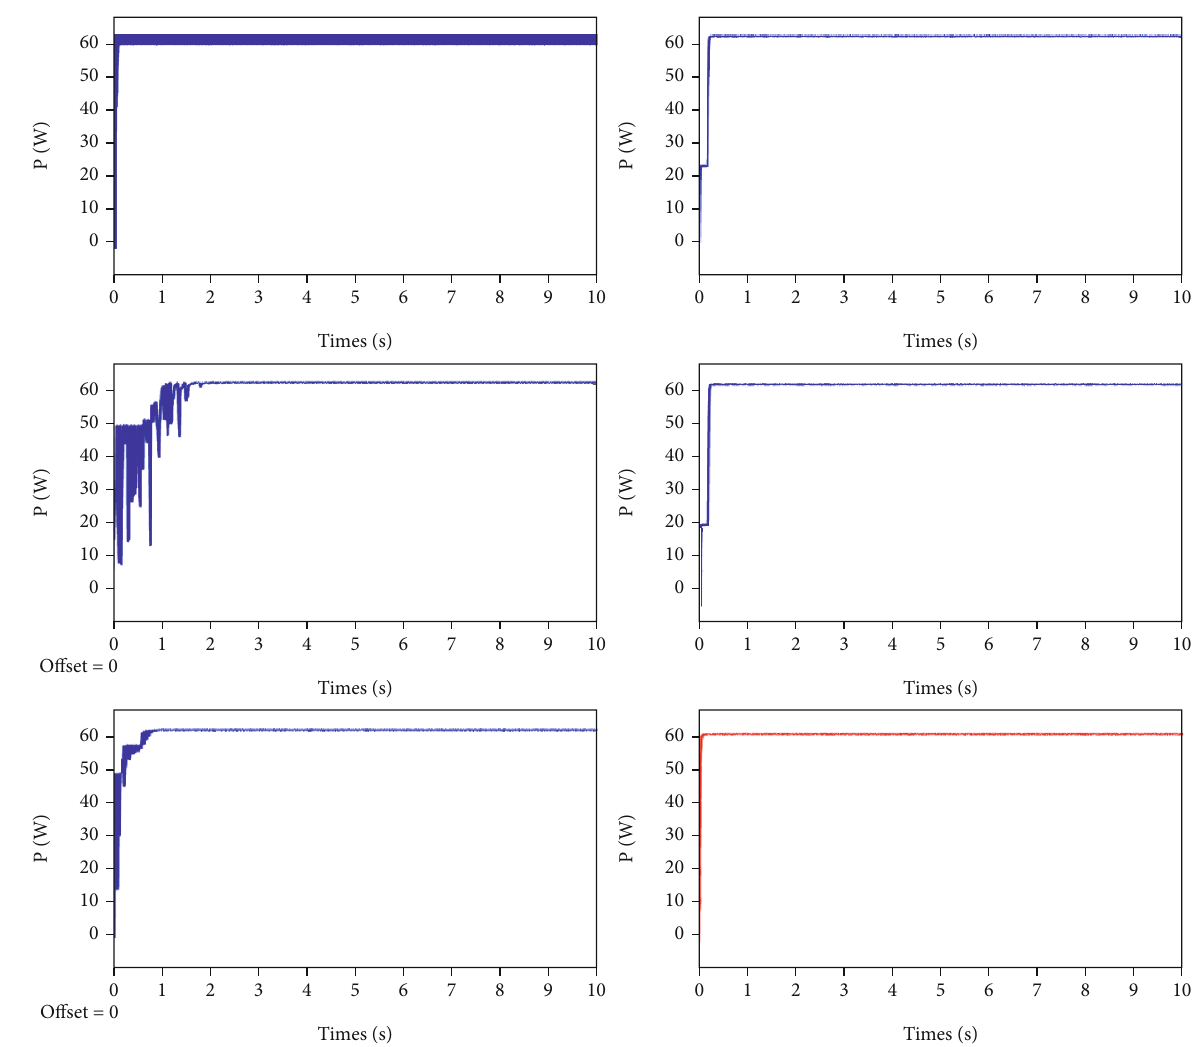
Figure 7: Simulation waveforms at STCs; PV array output power P&O, PSO, CUCKOO, GWO, WOA, and